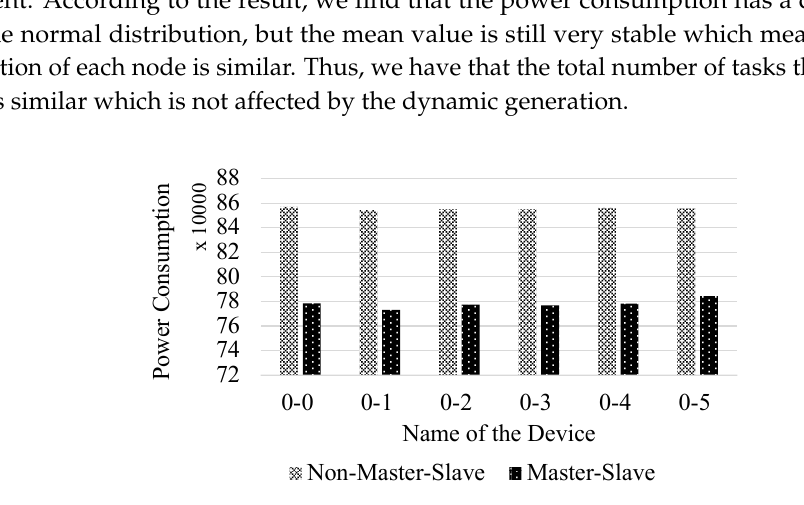
Figure 6. Power consumption of five edge nodes in a